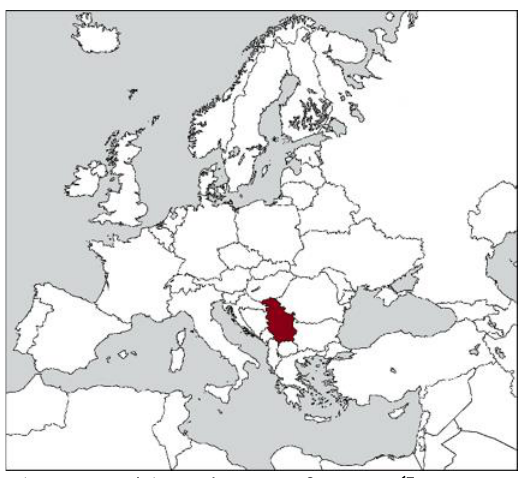
Figure 1. Serbia on the map of Europe ([Europe map Serbia],